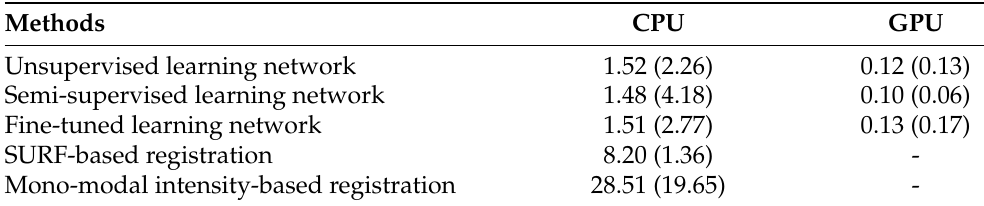
Table 4. Average execution times (and std. devs.) on CPU and GPU for the proposed registration networks and baseline